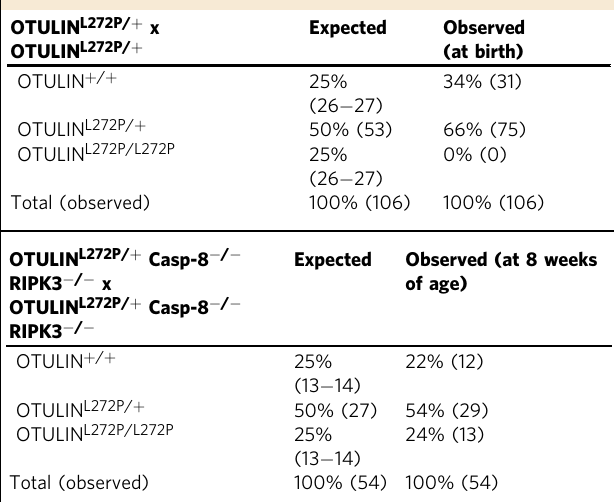
Table 1. depicting the number of offspring from the indicated intercrosses (observed and expected